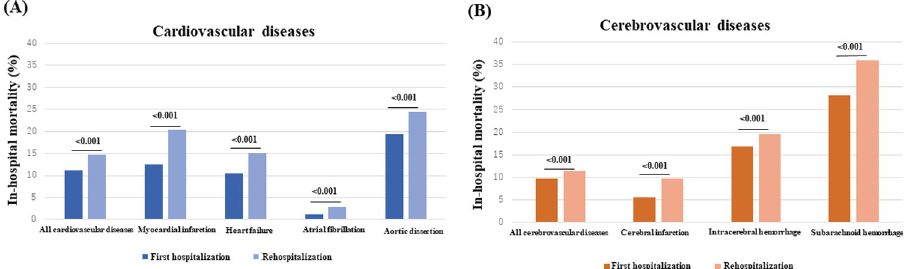
Fig 3. Comparison of in-hospital mortality between first hospitalization and rehospitalization due to cardiovascular disease (A) or cerebrovascular disease (B).